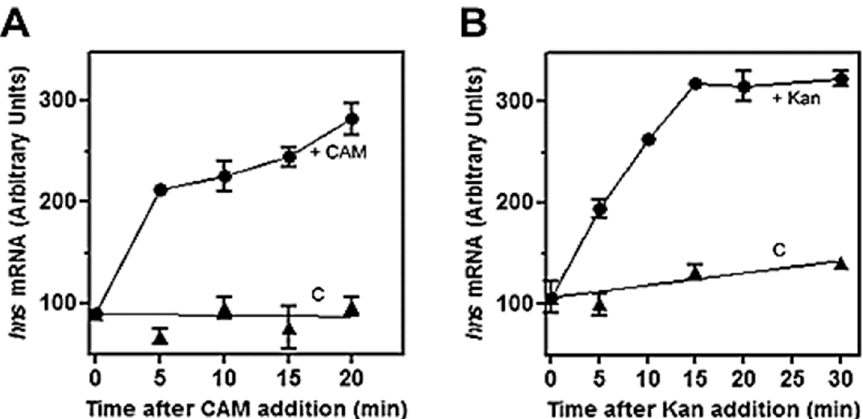
Figure 1. Effects of chloramphenicol and kanamycin on hns transcription in vivo. The E. coli strain MRE600 was grown at 37 °C in LB broth up to Abs 600 = 0.5–0.6 (exponential phase of growth) and at the indicated times after the addition of 200 µg/mL of chloramphenicol ( A ) or 300 µg/mL of kanamycin ( B ), cell aliquots were harvested for RNA extraction. About 10 µ g of total RNA were subjected to northern blot analysis and membranes hybridized with a [ 32 P]-labeled hns probe. Treated cells ( ● ) and control culture (C) in the absence of drugs ( ▲ ) are shown. Data represent the average of at least two independent experiments and standard deviation is reported.